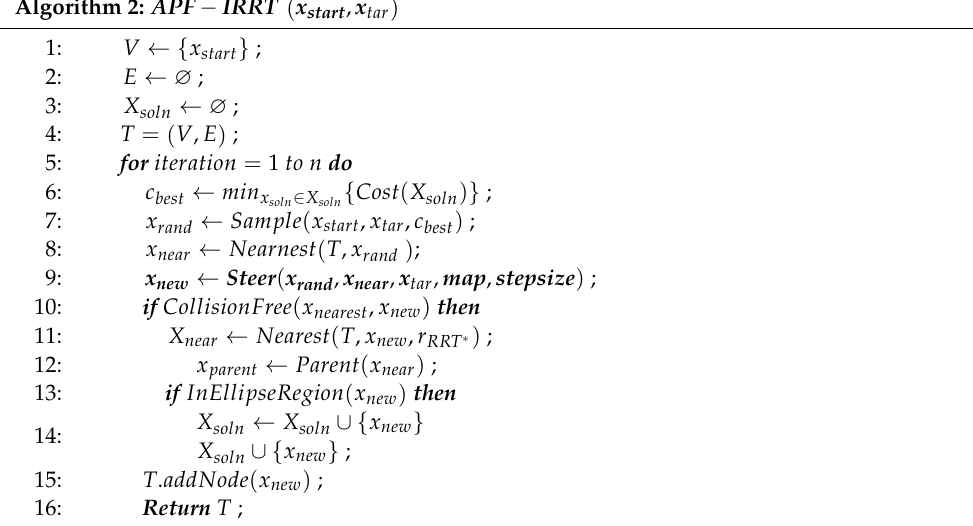
Algorithm 2: APF − IRRT * ( x start , x tar )